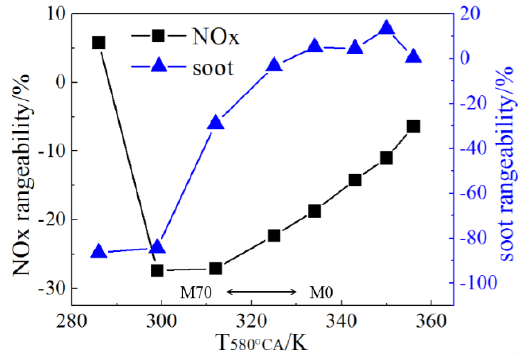
Figure 10. Influence of Miller timing on NO x and soot.